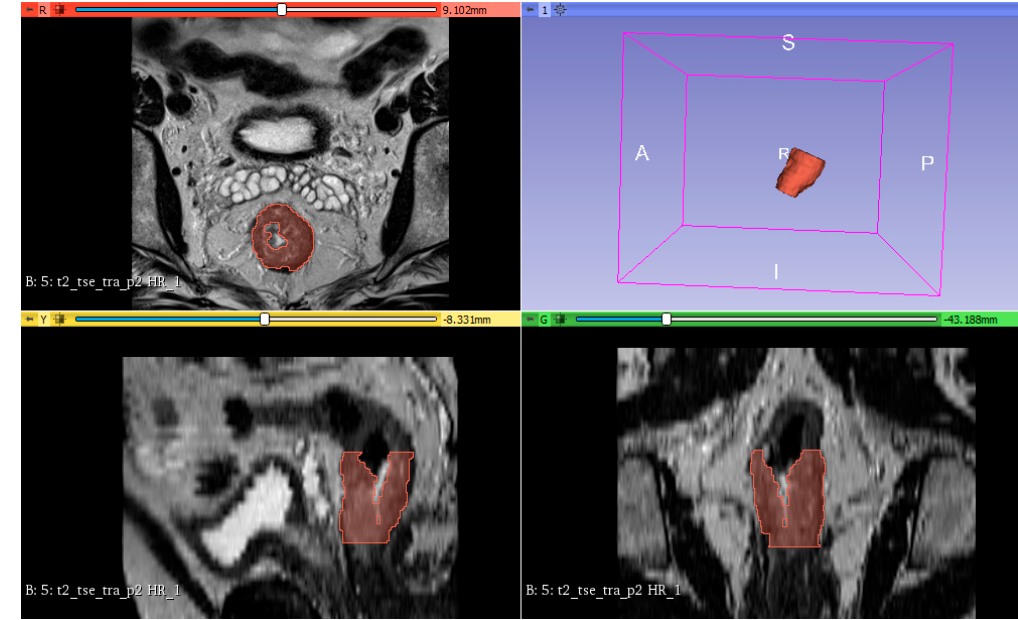
Figure 5. An example of rectal tumor VOI segmentation.